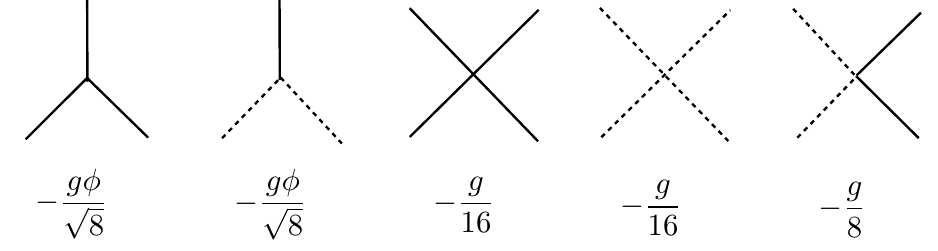
Figure 9 . The propagators for the (cid:17) , (cid:24) (cid:12)elds.